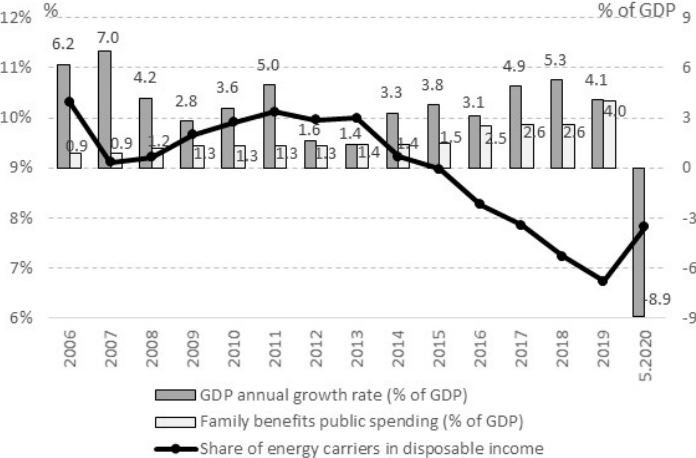
Figure 3. Factors influencing ratio of expenditure on energy carriers to average disposable income of Polish households per capita in the period 2006–May 2020 *. * projected economic growth in the second quarter 2020 (Year over Year). Source: own study based on [58–60].